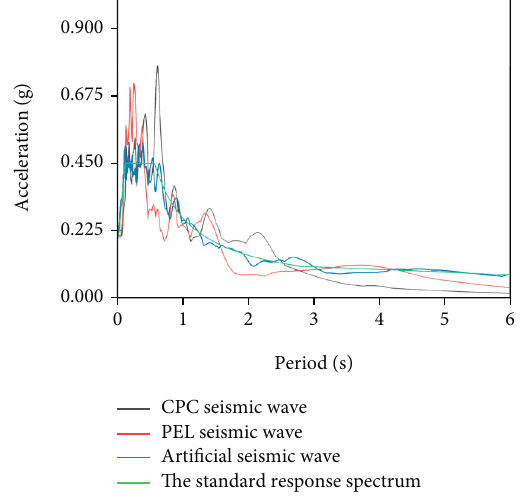
Figure 4: Acceleration response spectra of di ff erent seismic